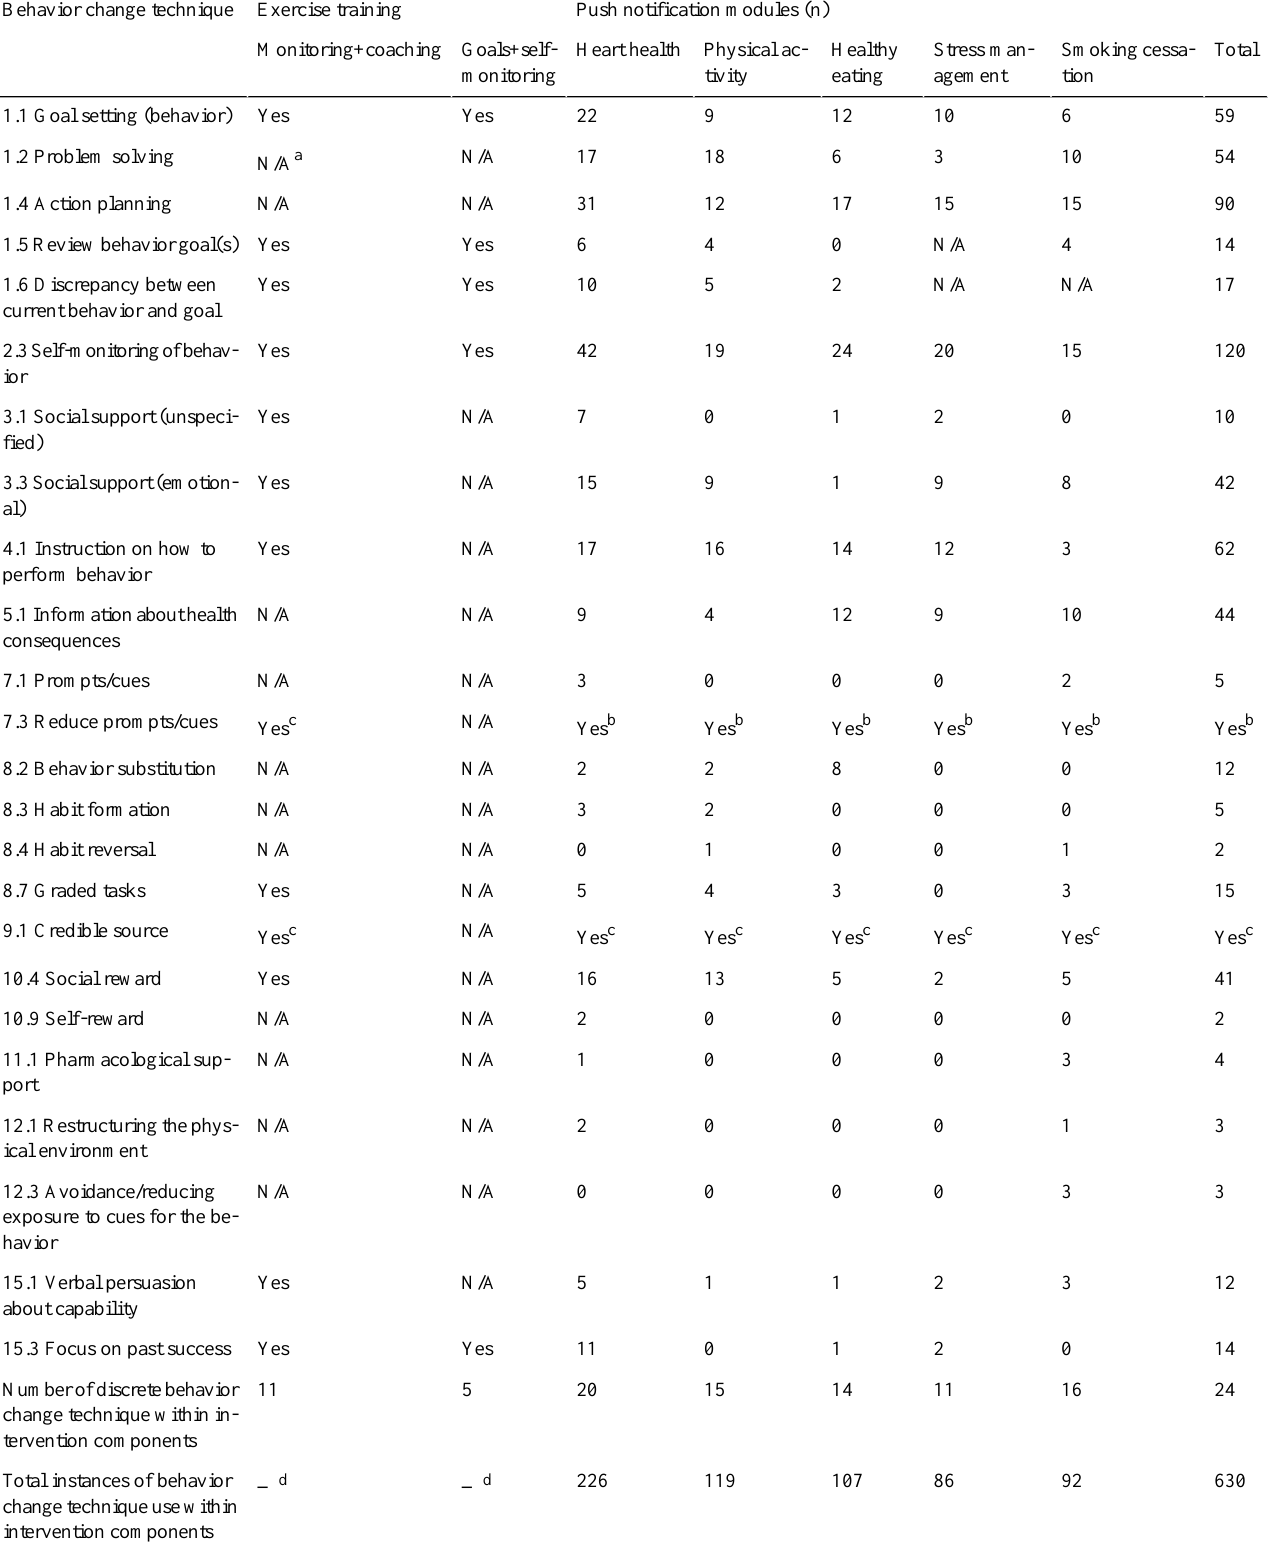
Table 2. Integration of behavior change techniques into Smartphone Cardiac Rehabilitation, Assisted self-Management exercise training and behavioral support intervention